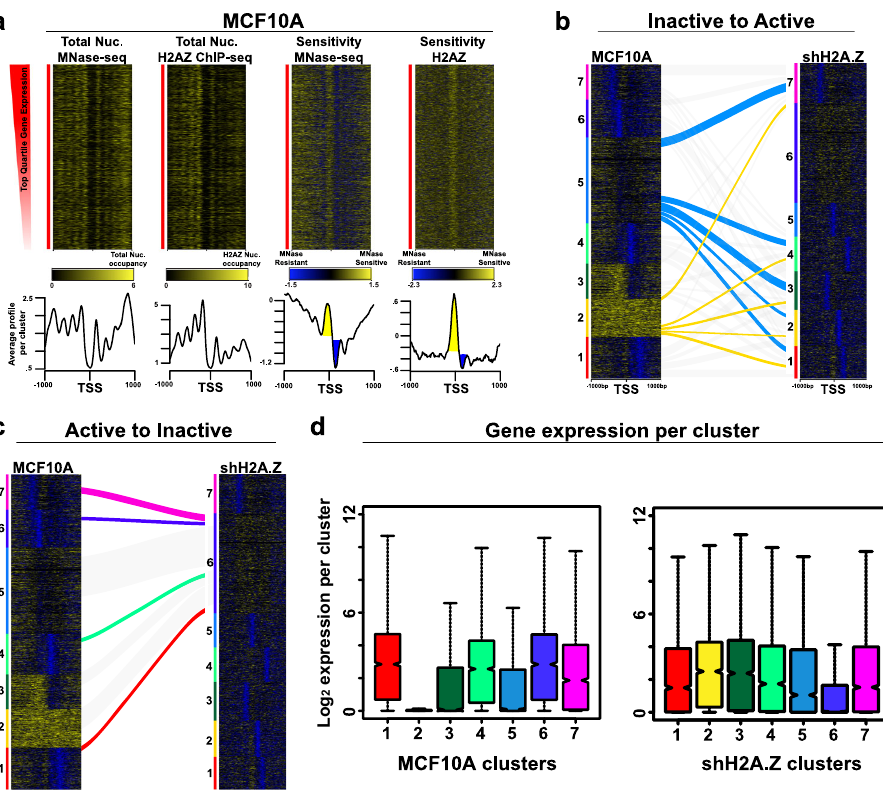
Fig. 2 Promoters with high nucleosome occupancy and TSS MNase sensitivity are highly expressed. a For the top quartile of expressing genes in MCF- 10A cells, total mTSS-seq nucleosomes and MNase sensitivity, and immunoprecipitated H2A.Z nucleosomes and H2A.Z MNase sensitivity were sorted based on their expression. Average pro fi les are shown below. The yellow peak shows the MSN at the TSS. The blue inverted peak shows the MRN at the + 1 position. b Alluvial diagram of how the silent cluster 2 and repressed cluster 5 change following their activation when H2A.Z is depleted from MCF-10A cells. c Alluvial diagram showing the fate of active promoter clusters following their inhibition of transcription when H2A.Z is depleted from MCF-10A cells. Line thickness is proportional to the number of promoters that change. d gene expression box plots for the different MCF-10A and shH2A.Z MNase- sensitive promoter classes. Box plots represent the data in quartiles with the median shown as a notch, with the middle 50% of the data contained in the box, and the minima and maxima shown with the upper and lower whiskers representing Q1 and Q4. RNA-seq was performed in three independent biological